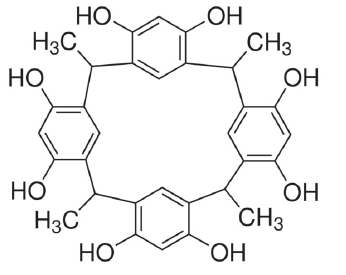
Figure 1. Molecular structure of C-methylcalix[4]resorcinarene